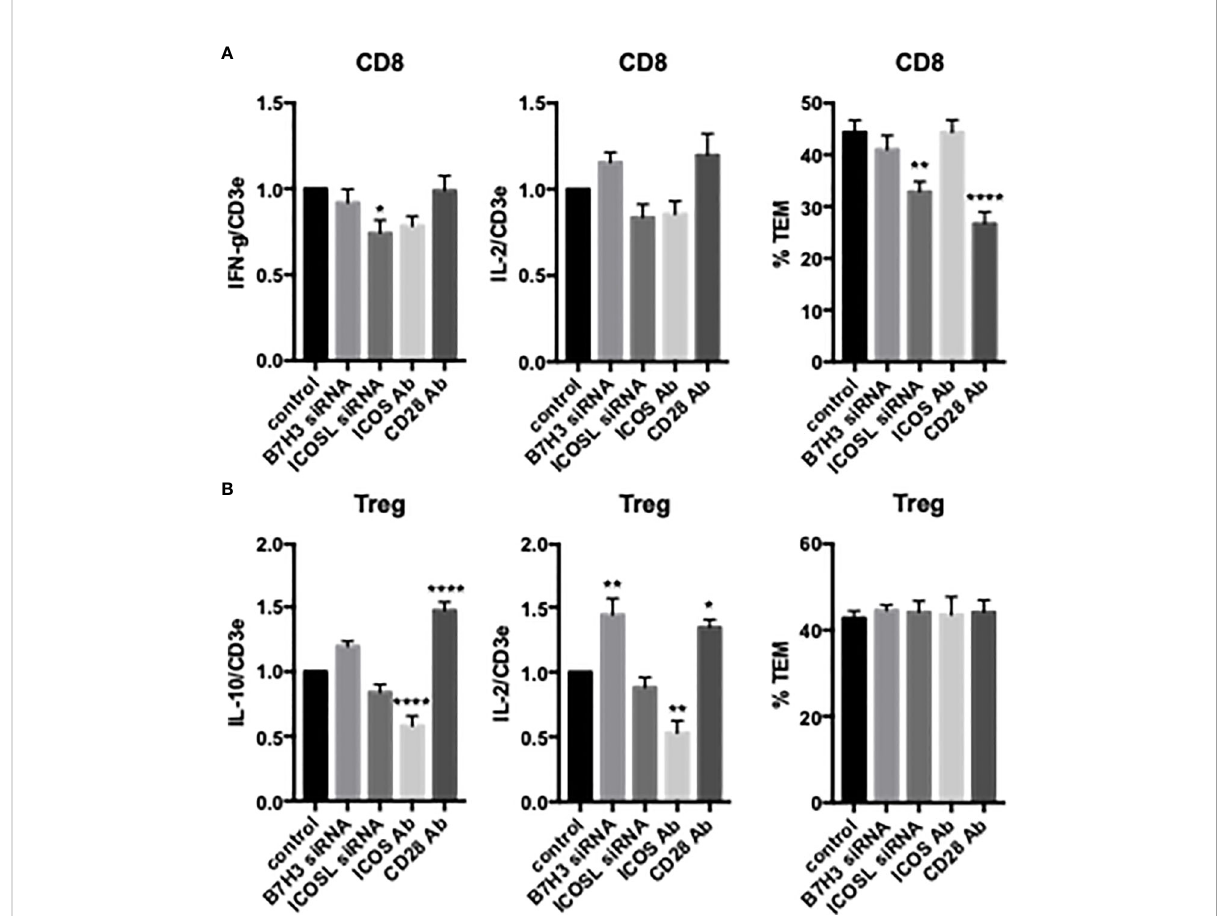
FIGURE 8 Effects of EC B7H3 and ICOSL knockdown by siRNA and T cell ICOS and CD28 blocking Abs on cytokine expression and TCR-TEM of activated/ expanded CD8 T EM and Treg. Cytokine expression (left and middle graphs) and TCR-TEM (right graphs) of activated/expanded CD8 T EM (A) and Treg (B) on CIITA HDMEC transfected with B7H3 siRNA or ICOSL siRNA and after pretreatment of T cells with ICOS blocking Ab or CD28